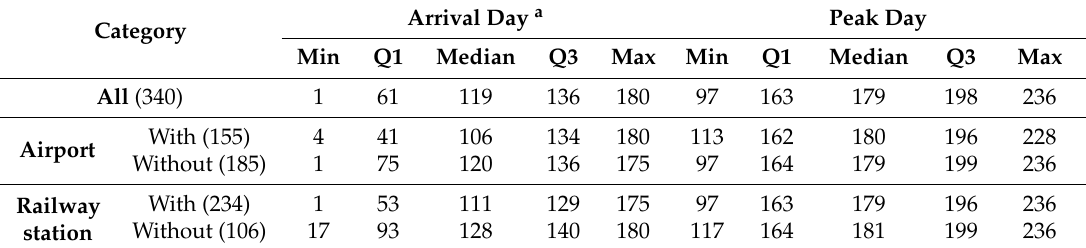
Table 1. Summary statistics of arrival days and peak days for 340 affected prefectures in mainland China.